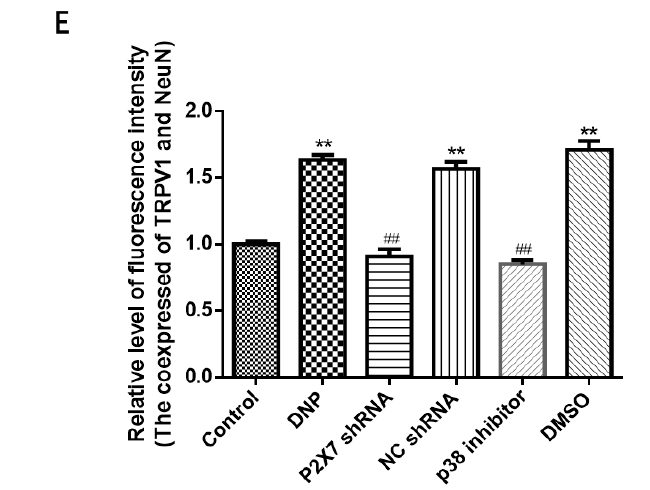
Figure 5. Measuring TRPV1 mRNA and protein levels and co-expression of NeuN and TRPV1 in DRG. ( A ) TRPV1 mRNA levels in the DRG. ( B ) TRPV1 protein bands in the DRG. ( C ) TRPV1 protein expression in DRG. ( D ) Co-expression of TRPV1 and NeuN in DRG. ( E ) Relative fluorescence intensity levels of NeuN and TRPV1 co-expression. TRPV1 mRNA, protein expression, and the co-expression of NeuN and TRPV1 in the P2X7 shRNA and p38 inhibitor groups were lower than in the DNP group. Blue staining (DAPI) marks the nucleus, green staining (NeuN) marks the neuron, red staining marks TRPV1, and the yellow signal is a combination of green and red signals. The scale bar represents 50 µm; data are shown as mean ± SEM based on at least three independent experiments, n = 6; ** p < 0.01 versus the Control group; ## p < 0.01 versus the DNP group.